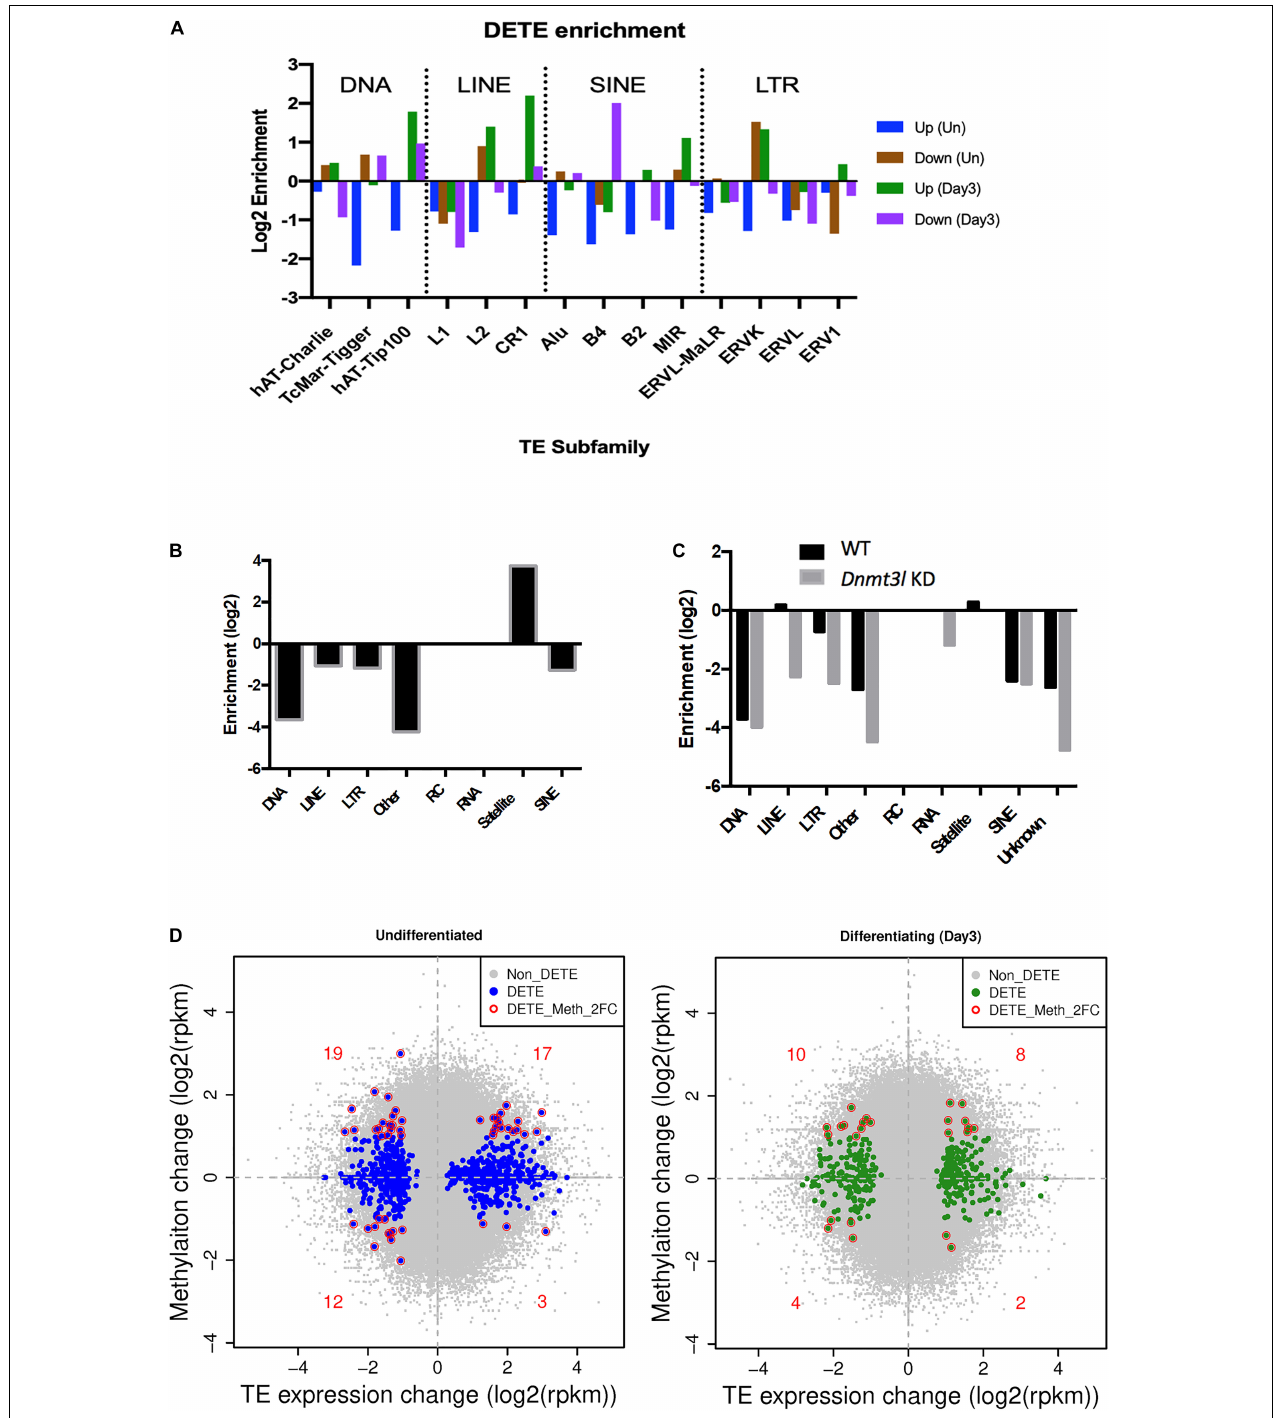
FIGURE 5 | Dnmt3l genotype associated differential TE expressions and DNA methylation levels in MSCs. (A) Significant changes of TE expression patterns were observed in Dnmt3l - / - undifferentiated and differentiating MSCs, compared to wild type MSCs. Blue, upregulated TEs in undifferentiated Dnmt3l KO MSCs, UP (Un). Brown, downregulated TEs in undifferentiated Dnmt3l KO MSCs, Down (Un). Green and purple indicate upregulated and downregulated TEs in differentiating MSCs at day 3 of osteogenesis induction, UP (Day3) and Down (Day3), respectively. (B) The DNA methylation is obvious low at TE regions in ES cells. In addition to repeat sequences, DNMT3L binding regions are mostly enriched in satellites in ES cells. (C) DNMT3L associated differentially methylated TEs in ES cells (D) Blue dots indicate Dnmt3l KO genotype associated differentially expressed TEs in undifferentiated MSCs (left); Green dots indicate Dnmt3l KO genotype associated differentially expressed TEs in differentiating MSCs (right); red circled dots indicate differentially expressed TE with a ≥ 2-fold change in methylation in Dnmt3l KD ES cells.